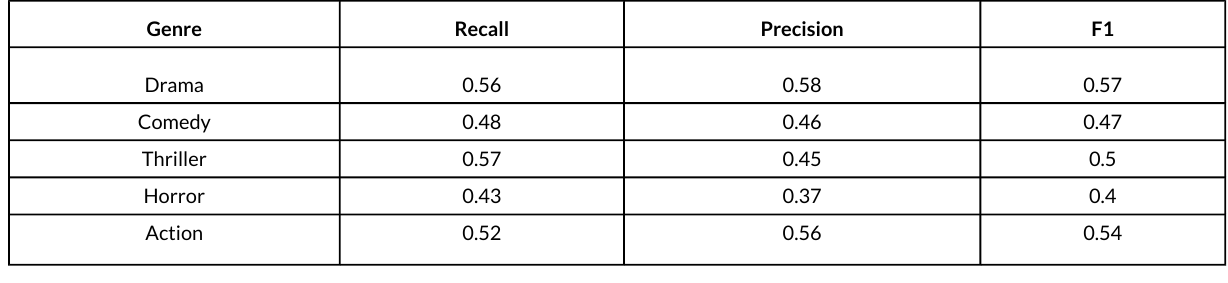
Table 3. Performance of our deep learning model on top five classes in the dataset.